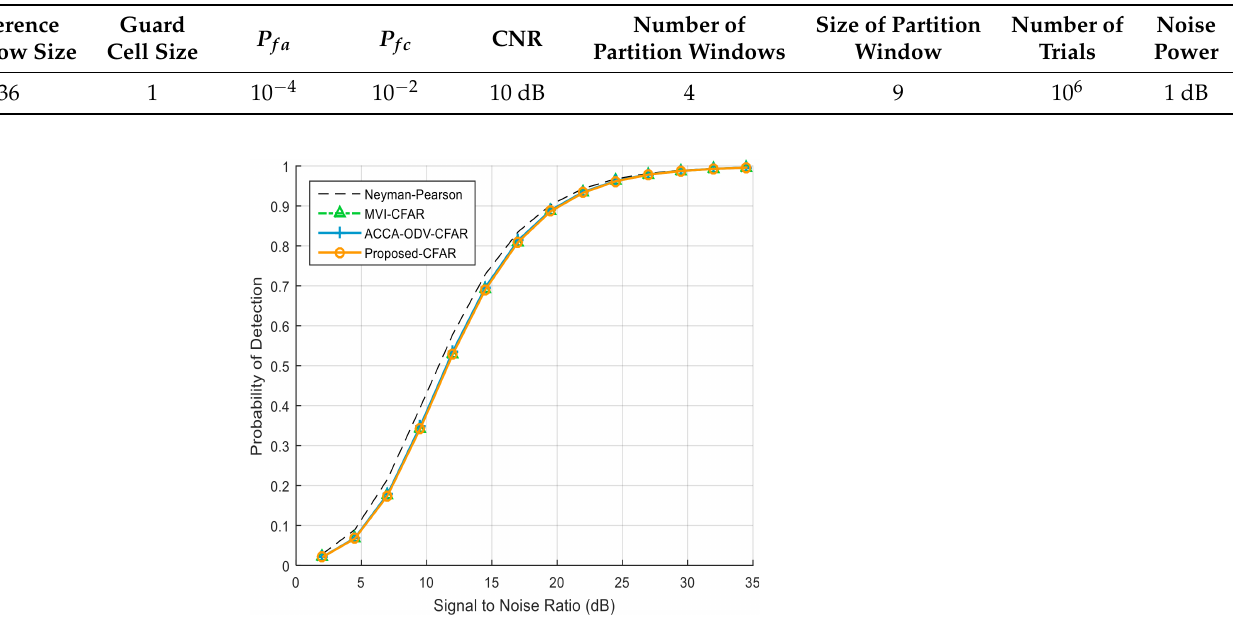
Table 1. Simulation parameters.